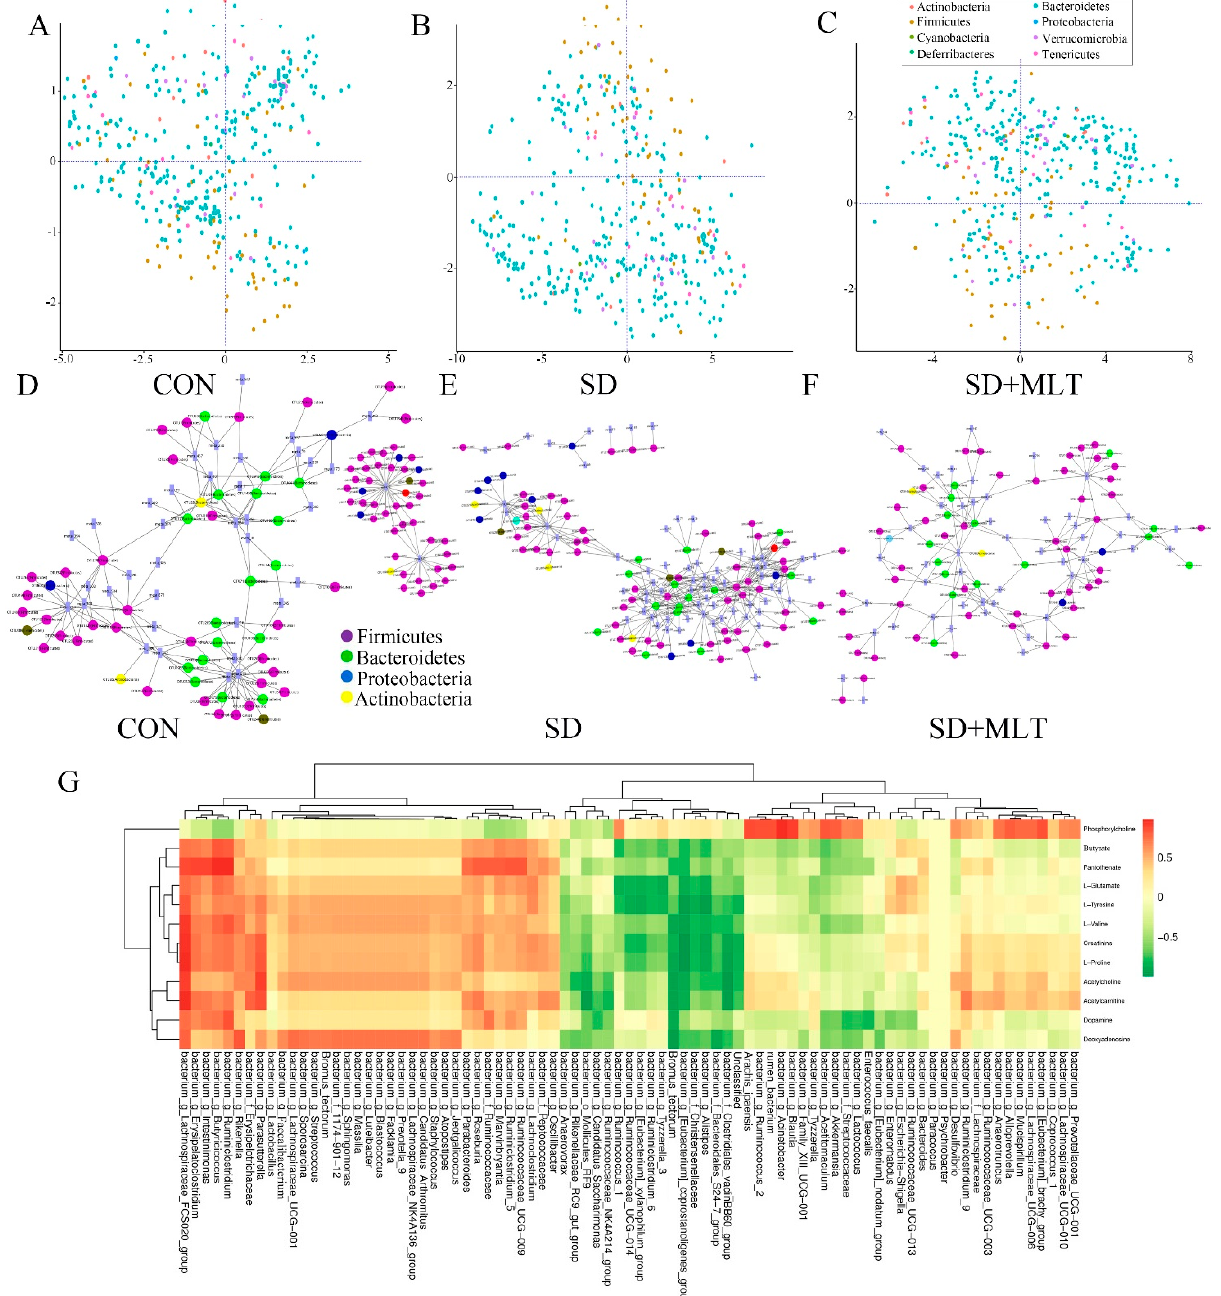
Figure 1. Correlation analysis between intestinal microbiota and metabolites in the colon of SD mice with or without melatonin supplementation ( n = 8). ( A – C ) Co-inertia analysis of differences in microorganisms among the CON ( A ), SD ( B ), and SD + MLT groups ( C ). ( D – F ) Correlation network analysis between intestinal microbiota and metabolites among the CON ( D ), SD ( E ), and SD + MLT groups ( F ). ( G ) Correlation of the most significant changes in intestinal microbiota and metabolites among the CON, SD, and SD + MLT groups. CON: non-sleep-deprived control group; SD: sleep deprivation group; SD + MLT: SD + melatonin supplement group.